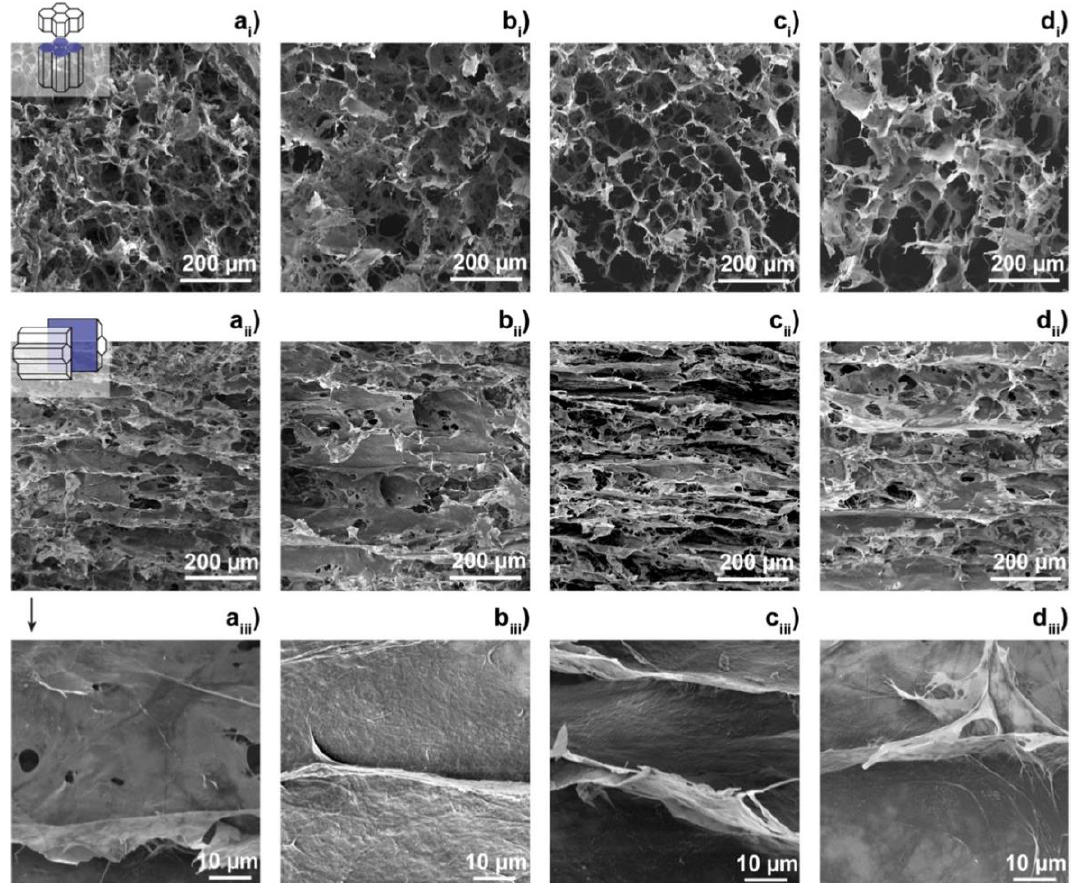
Figure 6. Scanning electron microscopic (SEM) images of ( a ) cellulose nanofiber aerogel, ( b ) cellulose nanofiber aerogel impregnated with a small content of cellulose acetate, ( c ) cellulose nanofiber aerogel impregnated with a high content of cellulose acetate, and ( d ) cellulose nanofiber aerogel impregnated with cellulose nanocrystals. ( a i – d i ): the cross-section of the samples perpendicular to the